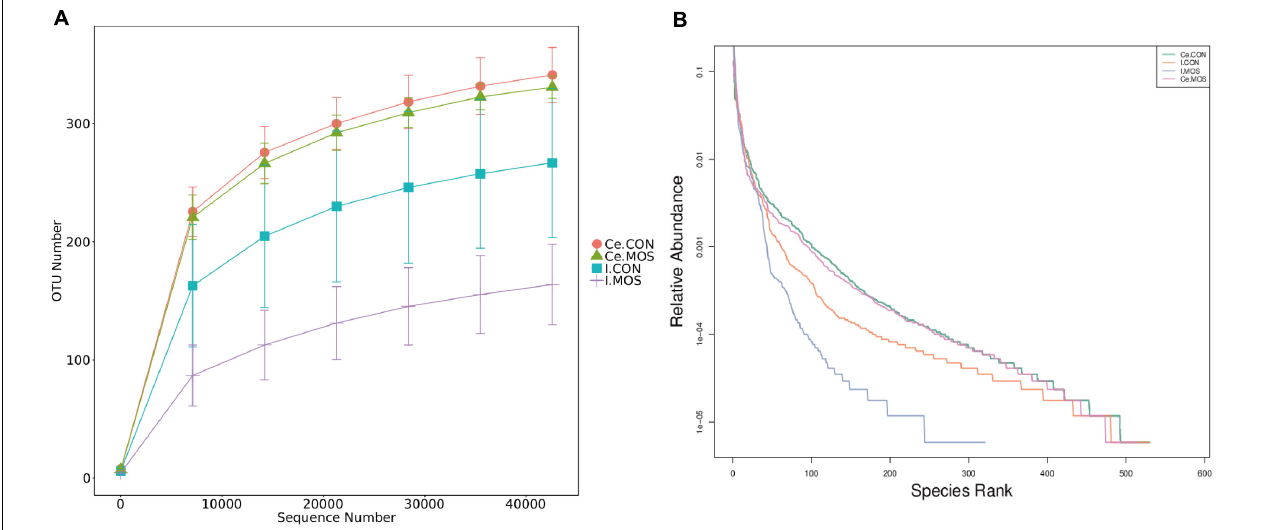
FIGURE 4 | Rarefaction (A) and rank–abundance (B) curves. I.CON means ileal digesta samples from pigs fed with the basal diet. I.MOS means ileal digesta samples from pigs fed with a basal diet supplemented with 3 g/kg MOS; Ce.CON means cecal digesta samples from pigs fed with the basal diet; Ce.MOS means